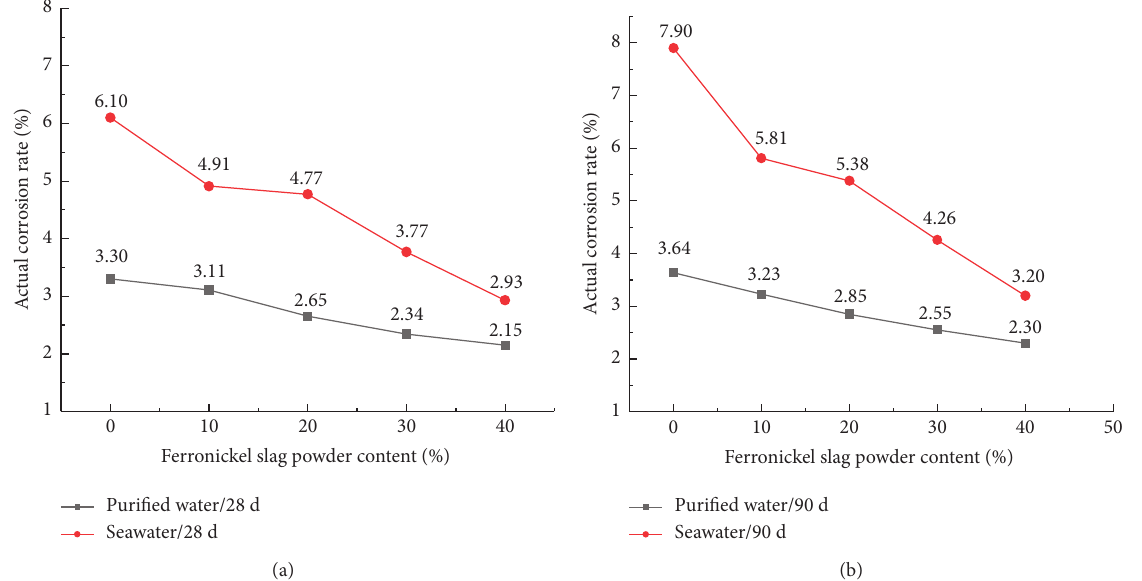
Figure 13: The actual corrosion rate of the steel bars embedded in the cement soil cured for (a) 28 days and (b) 90 Table 7: The pore characteristics of the cement soil containing ferronickel slag powder at a curing period of 60 days. Sample